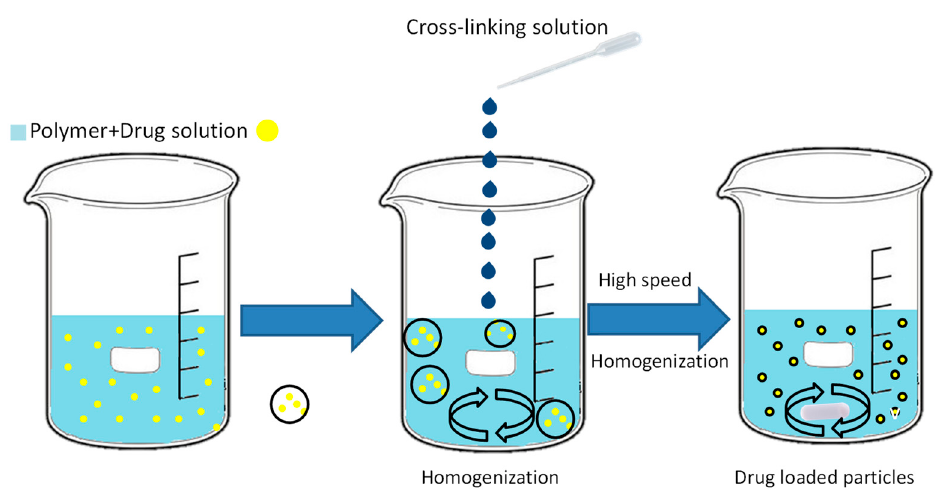
Figure 2. Encapsulation using ionotropic gelation techniques.